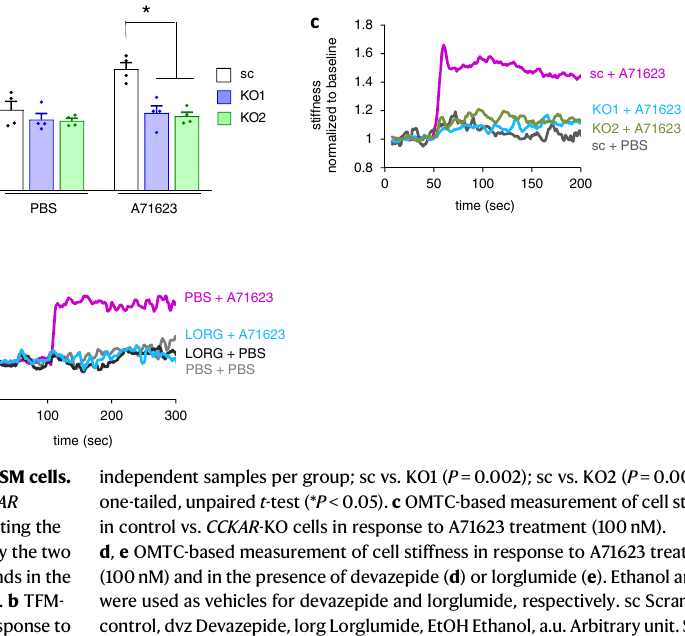
independent samples per group; sc vs. KO1 ( P =0.002); sc vs. KO2 ( P =0.0004); one-tailed,unpaired t -test (* P <0.05). c OMTC-based measurement of cellstiffness in control vs. CCKAR -KO cells in response to A71623 treatment (100nM). d , e OMTC-based measurement of cell stiffness in response to A71623 treatment (100nM) and inthe presenceof devazepide ( d ) or lorglumide ( e ).Ethanol and PBS were used as vehicles for devazepide and lorglumide, respectively. sc Scrambled control,dvzDevazepide,lorgLorglumide,EtOHEthanol,a.u.Arbitraryunit.Source data are provided as a Source Data fi